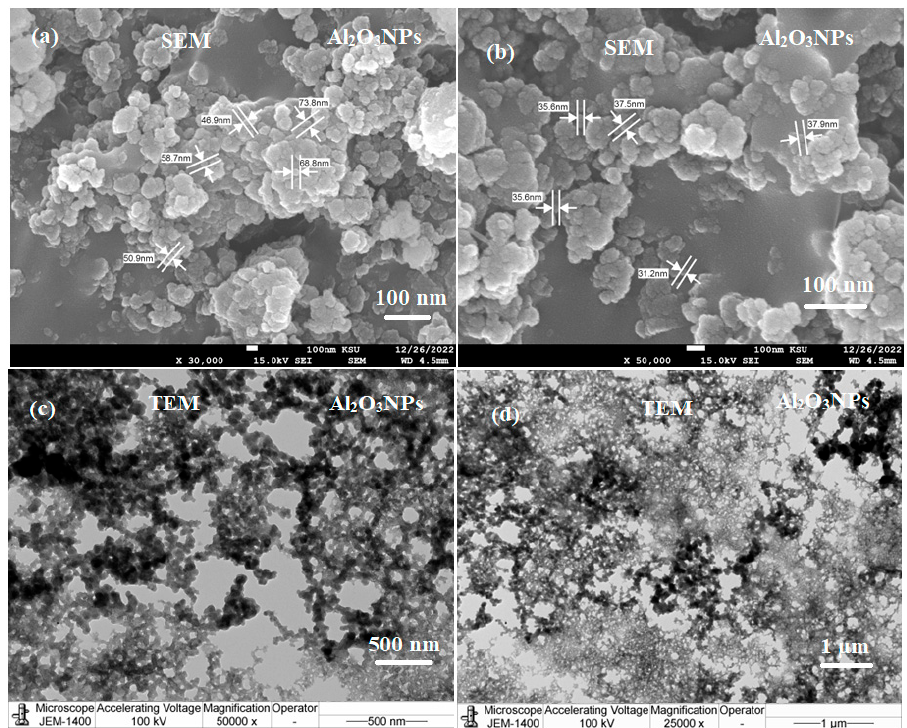
Figure 3. ( a , b ) SEM and ( c , d ) TEM images of Al 2 O 3 NPs synthesized using Lavandula spica flower extract measured at different magnifications.